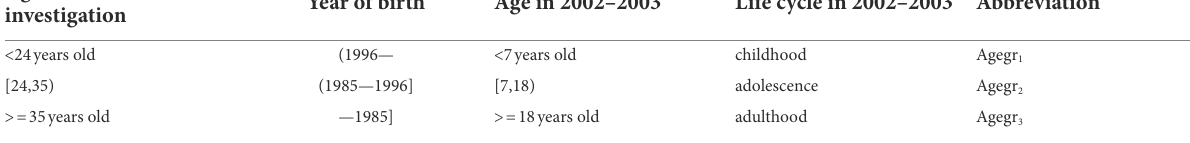
TABLE 1 Division of birth age stage of respondents. Age at the time of